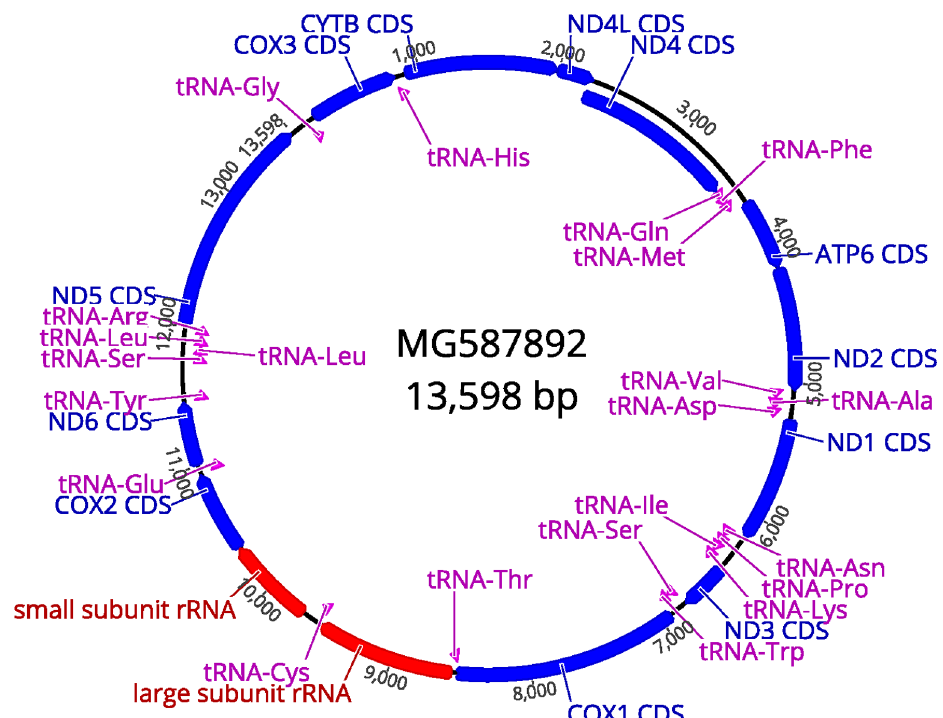
Figure 2. Graphical representation of the complete mitochondrial genome of D. caninum R166 (MG587892) including the organization and direction of 36genes within the mitochondrial genome.